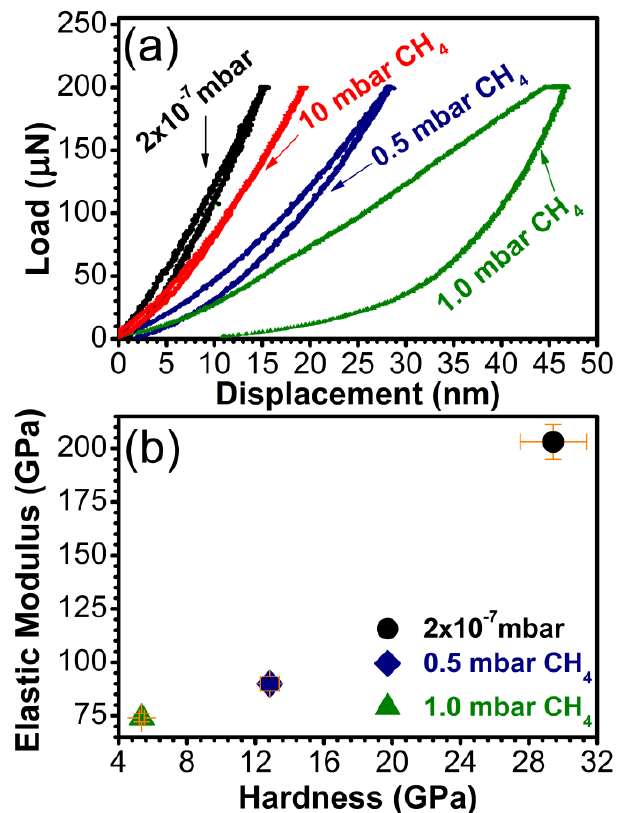
Figure 9. ( a ) Characteristic load vs . displacement curves and ( b ) Hardness and elastic modulus for carbon samples synthesized by PLD in vacuum and in 0.5, 1, or 10 mbar CH 4 pressure on buffered Si (100)